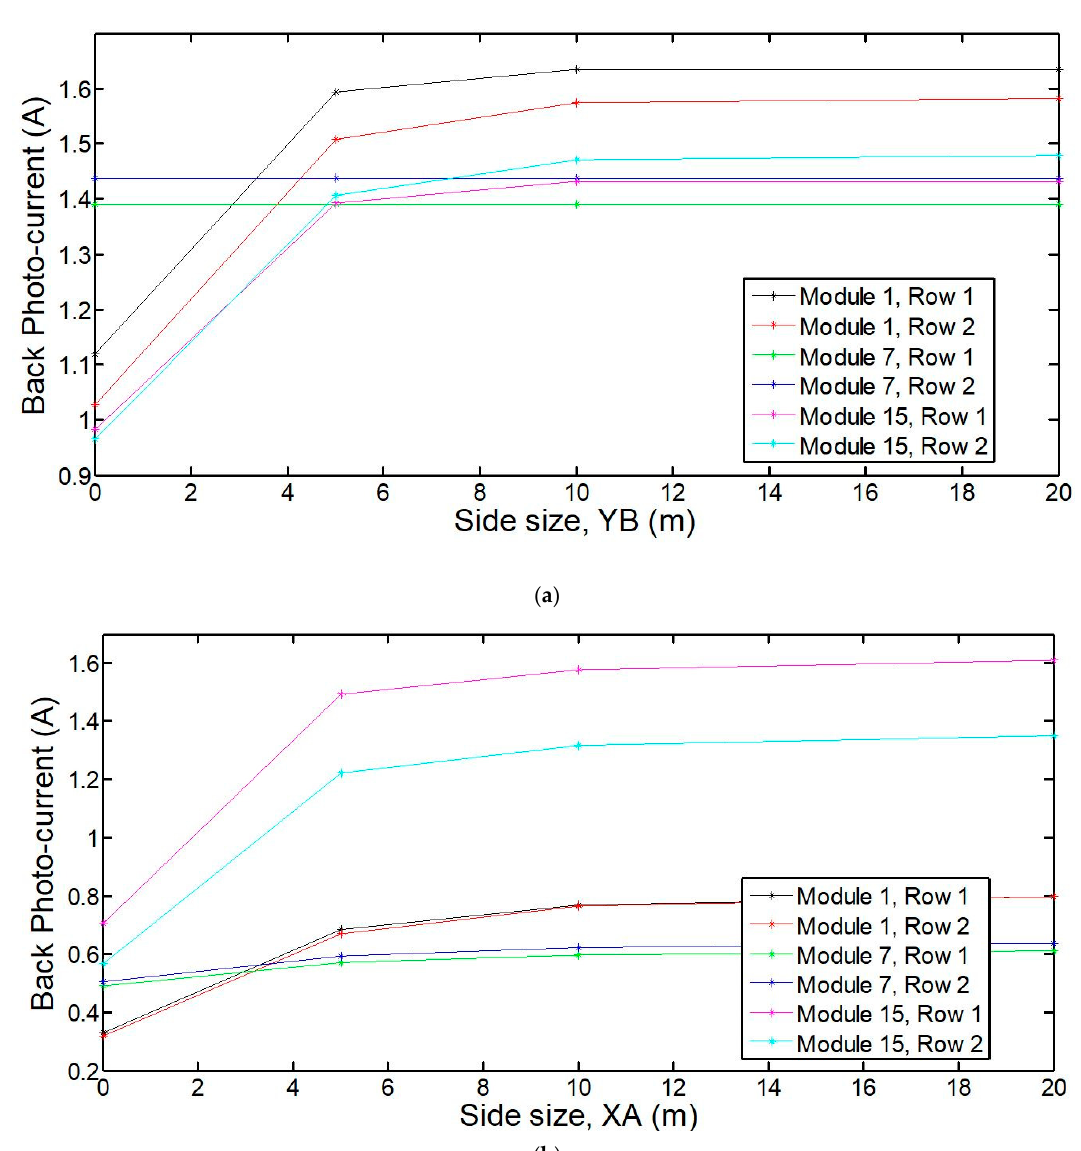
Figure 6. Back short circuit current values of the modules at the positions iy (or ix ) = 1, 7, 15 of both the two rows forming the 30-module fixed PV string ( a ) and PV string with uniaxial horizontal solar tracker ( b ), as a function of the YB and XA parameters, respectively. Note that (see the schematics of Figure 1) the modules at the mentioned positions iy (or ix ) = 1, 15 are at the PV string extremities, while the modules at the position iy (or ix ) = 7 are approximately at the PV string center. The back short circuit current values are calculated by the model, with reference to the Catania (Italy) latitude, at 10 a.m. of day n. 79 (year 2018), considering the same settings used to obtain the graphs of Figure 5.